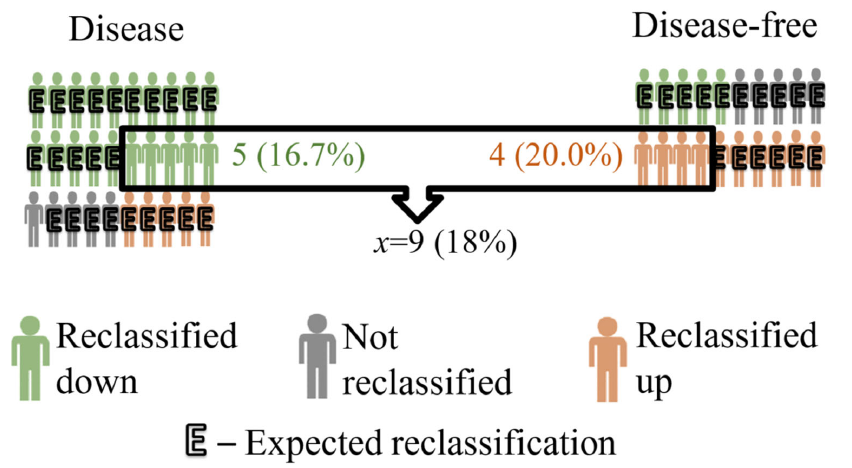
Figure 1. Method for presenting variable x , i.e., the number of correct reclassifications reduced by the random number of correct reclassifications after adding a new variable to the logistic regression model.